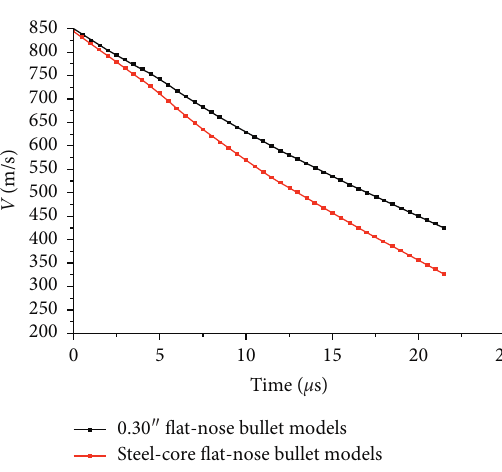
Figure 12: Velocity-time diagram of the bullet (10% 333 FGM + 4mm Al